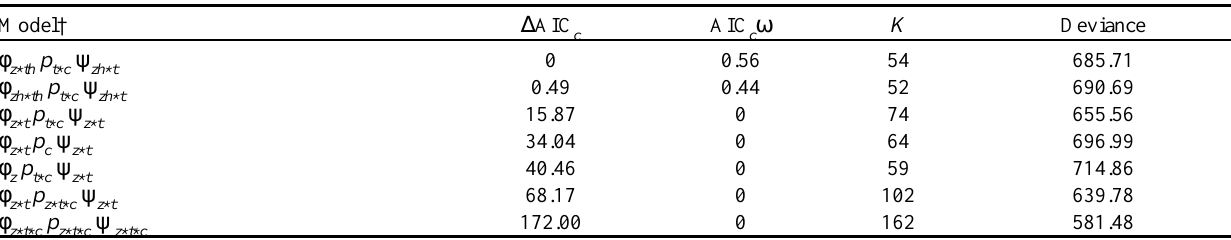
Table 2 . Model selection of regional movements of radio-marked and neck-collared Canada Geese ( Branta canadensis maxima ) near Montréal, Québec, 2004. D AICc, AICc w , and number of parameters (K) of the multistate models are presented. The minimum AICc = 2328.839 for the top-ranked model.